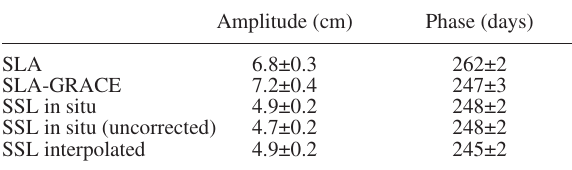
t able 4. – Annual amplitudes and phases of spatially averaged SLA from altimetry before and after the removal of the mass component from GRACE and the SSL from in situ profiles (both corrected and uncorrected) and interpolated data over the whole Mediterranean basin for the period